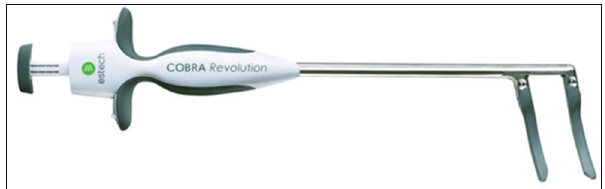
Figure 3: Cobra TM Revolution Bipolar Clamp (Estech, San Ramon, CA, USA).